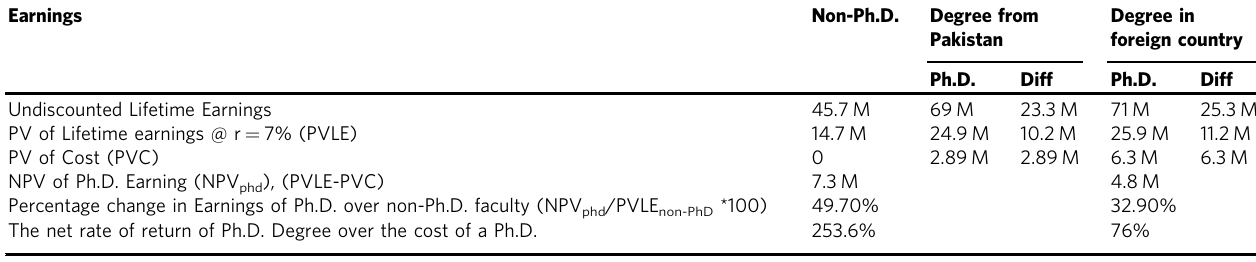
Table 8 Earning ’ s net present value of male Ph.D. over non-Ph.D. faculty (PKR). Earnings